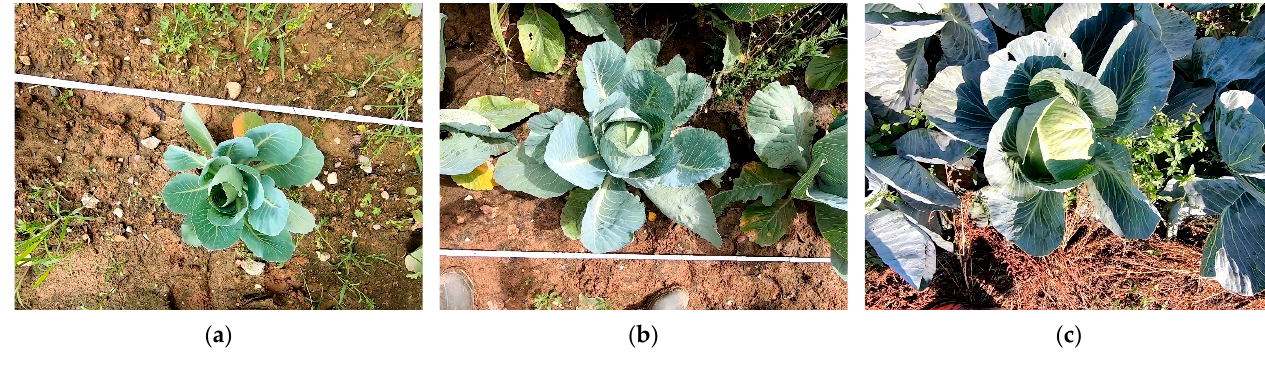
Figure 1. Cabbage plants of BBCH stage 41 ( a ), 45 ( b ), and 48 ( c ). Ten randomly picked cabbage plants of each growth stage were harvested and meas- ured to validate the calculated fruit volumes and leaf areas. To determine the fruit volume, the circumference of the cabbage head was measured. The metric volume (V) was esti- mated as